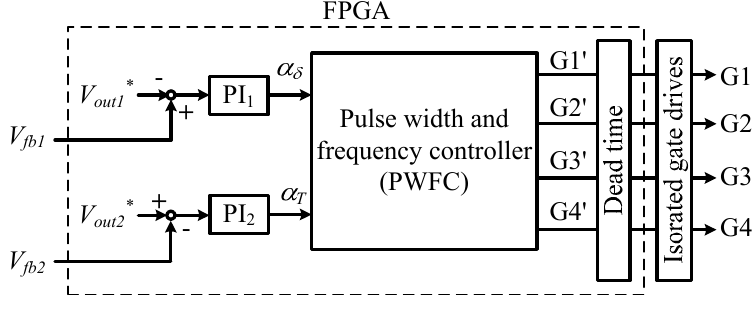
Figure 3. Control block diagram of proposed circuit.